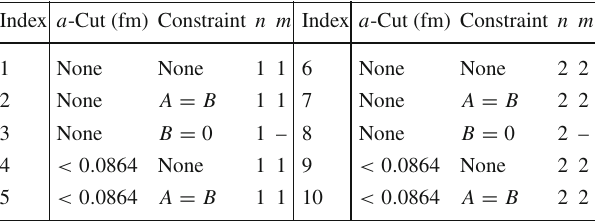
Table 10 Different fit forms used to estimate the continuum extrapo- lation systematic